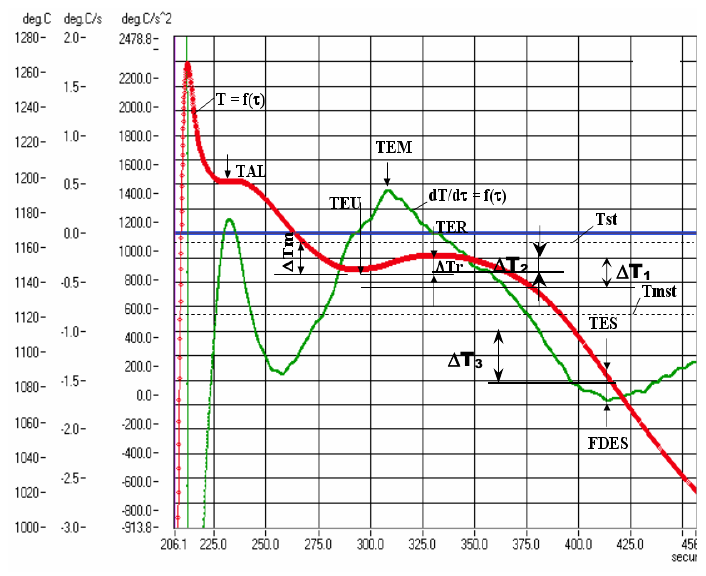
Figure 2. Representative solidification temperatures and undercooling degrees ( Δ T) compared to equilibrium temperature in stable (graphitic) (T st ) and metastable (carbidic) (T mst ) systems of ductile cast iron [17].